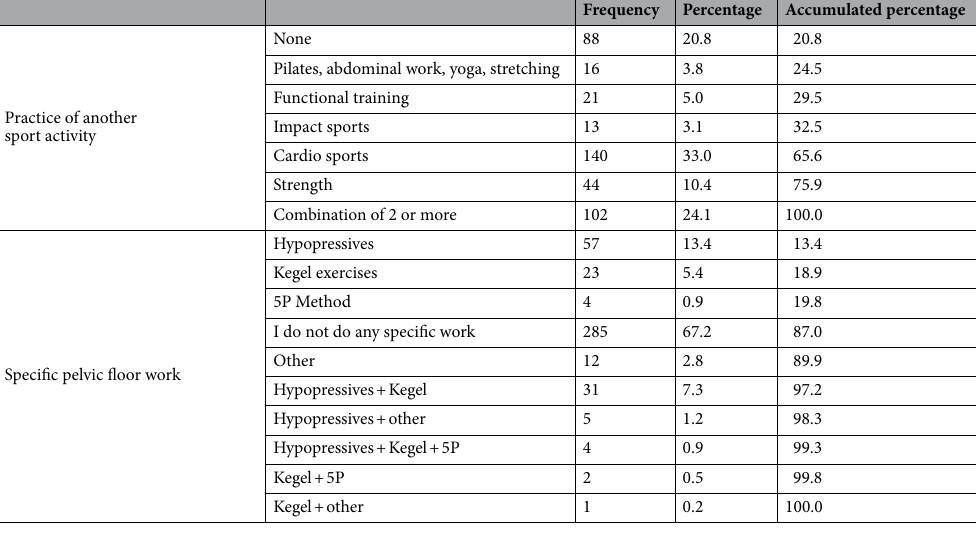
Table 1. Characteristics of the study